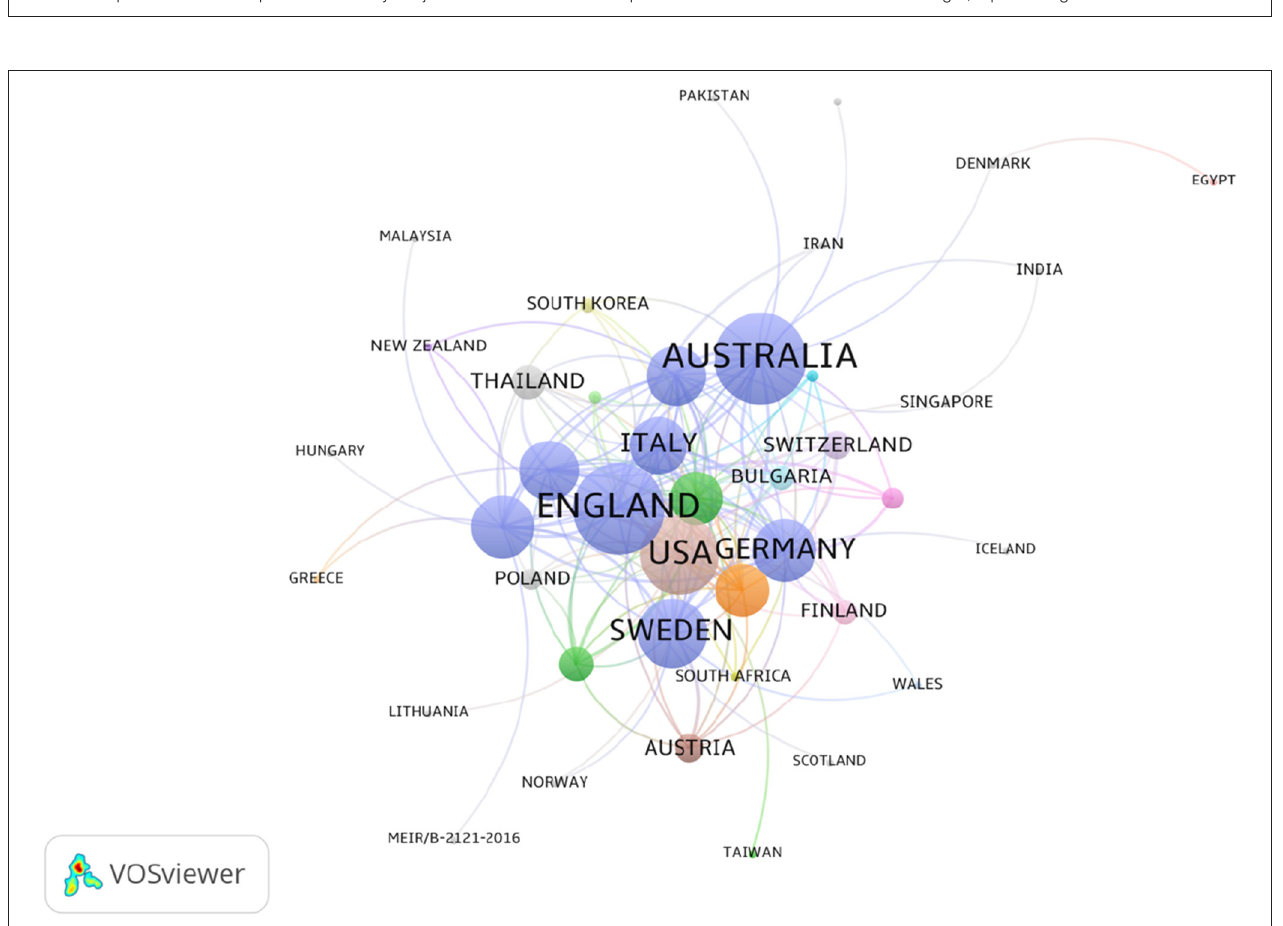
FIGURE 4 | Map of countries/regions that published articles on PMS/PMDD during 1945–2018.